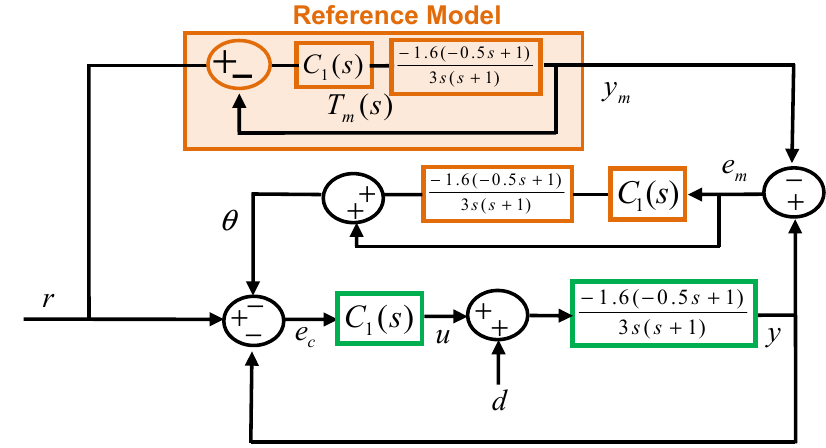
Figure 13. Implementation of the ML-MR PID-IM control structure for disturbance rejection control of the liquid level of the reboiler model.